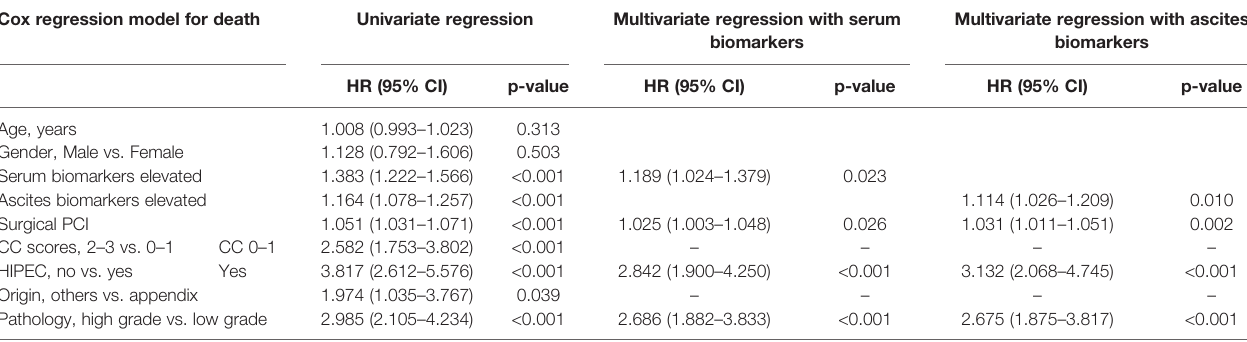
TABLE 4 | The univariate and multivariate Cox regression model of biomarkers and survival. Cox regression model for death Univariate regression Multivariate regression with serum